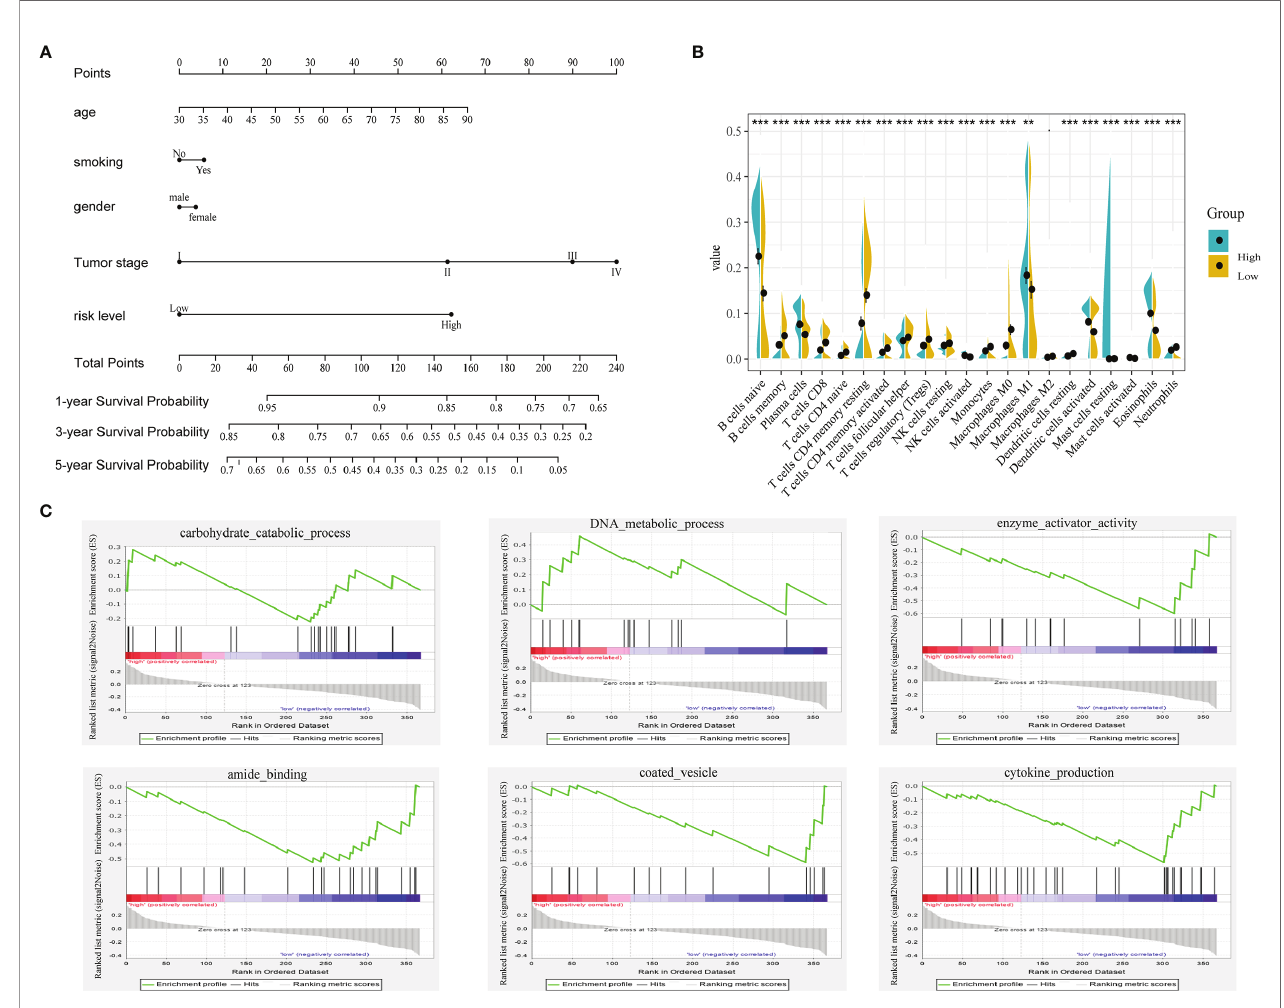
FIGURE 6 | (A) Nomogram predicting the OS in LUAD patients containing the risk level. (B) 22 immune cell distributions in LUAD based on risk level using CIBERSORT. (., NS; **, p<0.01; ***, p<0.001) (C) GSEA analysis based on the median value of risk